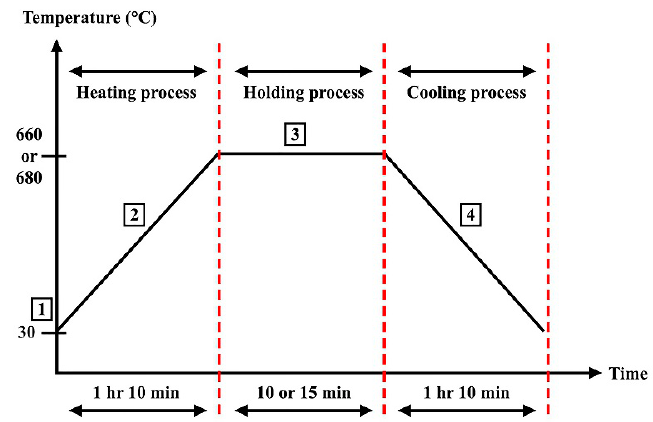
Figure 2. Profile of brazing parameters used in the experiment.